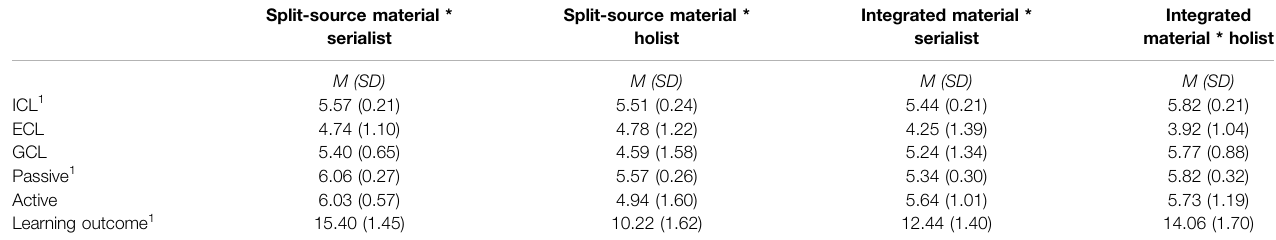
TABLE 6 | Means and standard deviation of all dependent variables in study 2.